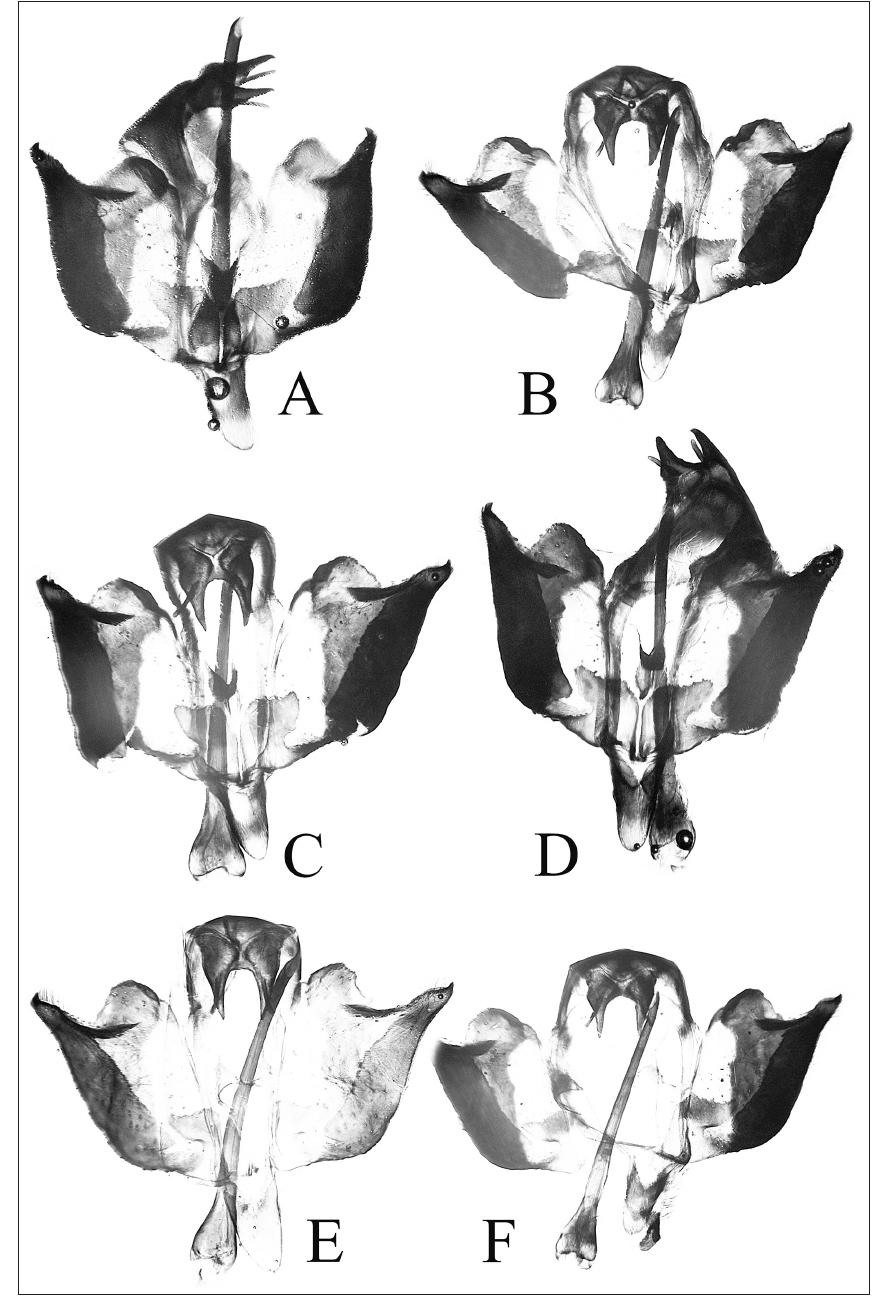
Figure 1. Male genitalia of Driopa mnemosyne (Linnaeus, 1758) from different locations: A – Kirghizia , Suusamyrtoo Mts., right shore of Suusamyr River, 2300 m; B – Russia, Caucasus, Teberda; C – EU, Slovakia, Boleraz ; D – Kirghizia , Kirghiz Mts., Issyk-Ata Valley, 2000 m; E – Kirghizia , Alai Mts., Kul - Kush Valley; F – Kazakhstan , Transili Alatau Mts., Bolshaya Almaatinka Valley, 2500